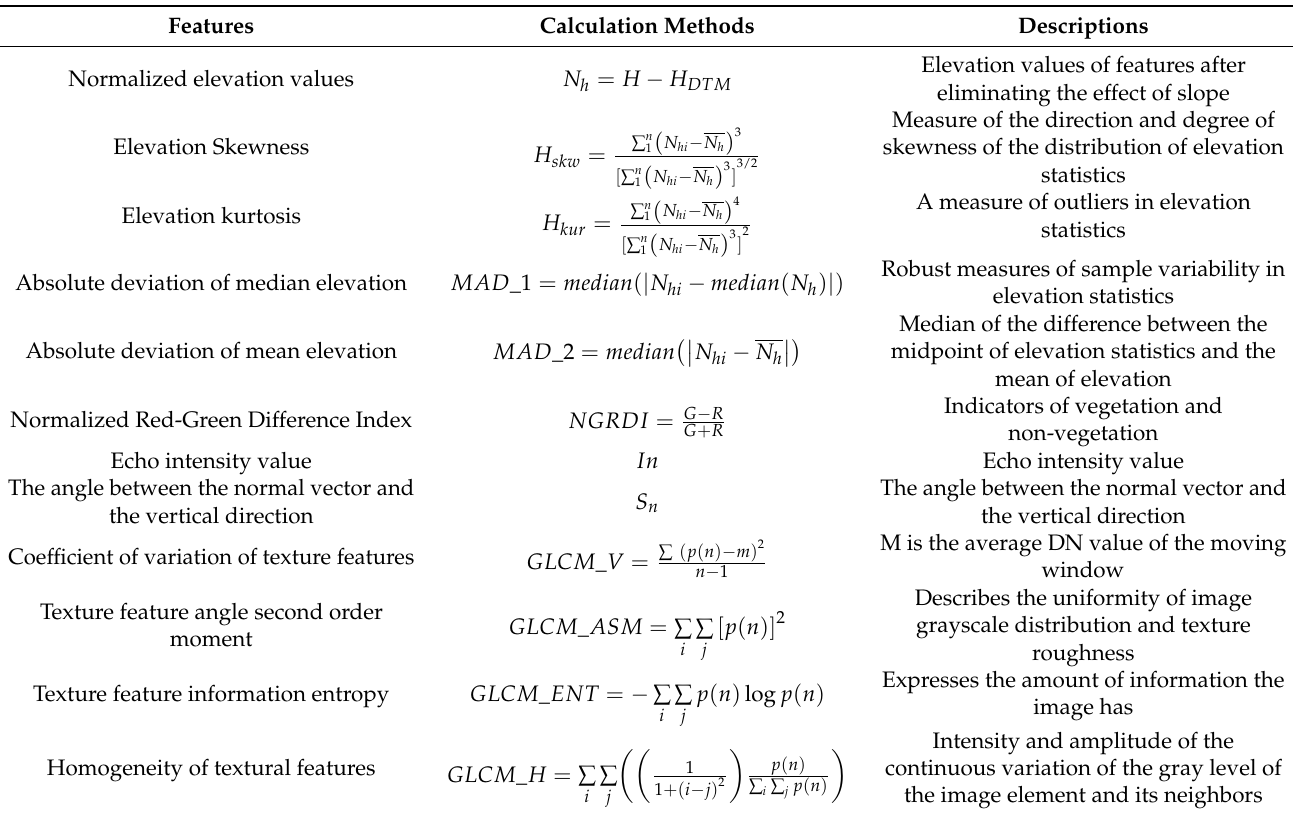
Table 1. Statistical results of point cloud data